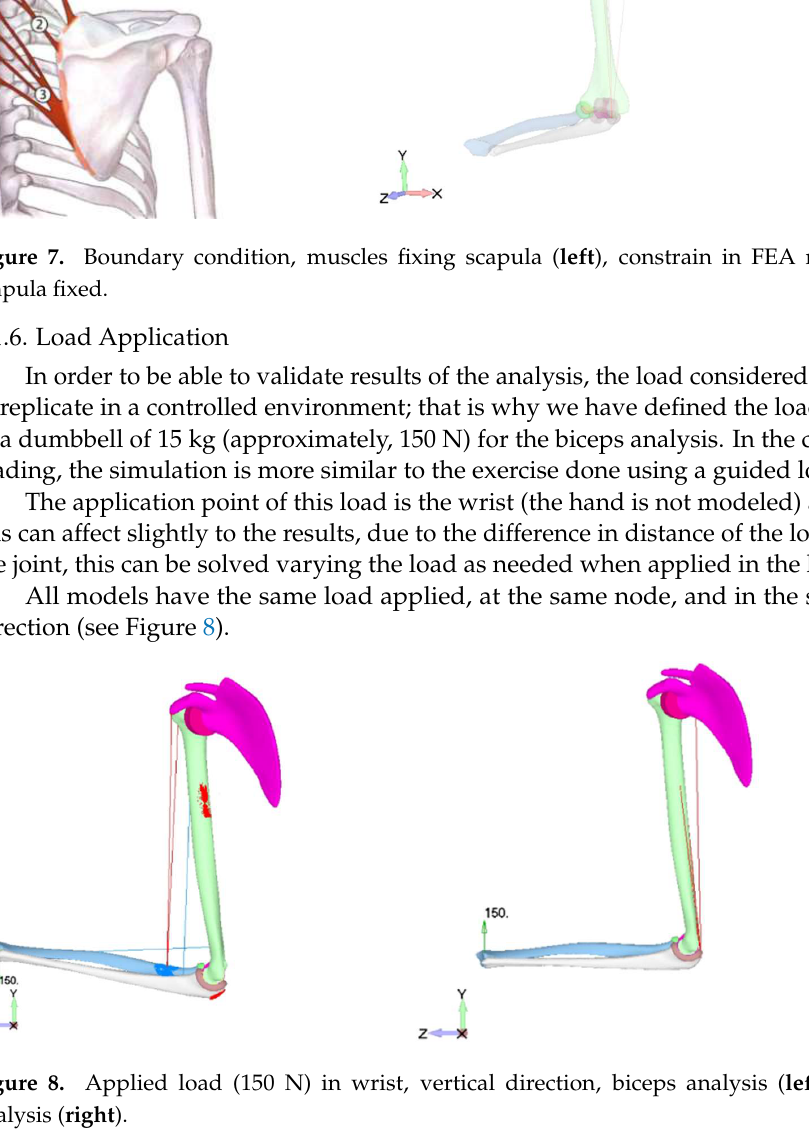
( right ). analysis ( right